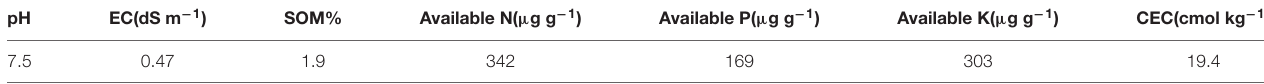
TABLE 3 | The chemical properties of the experimental soil for Experiment